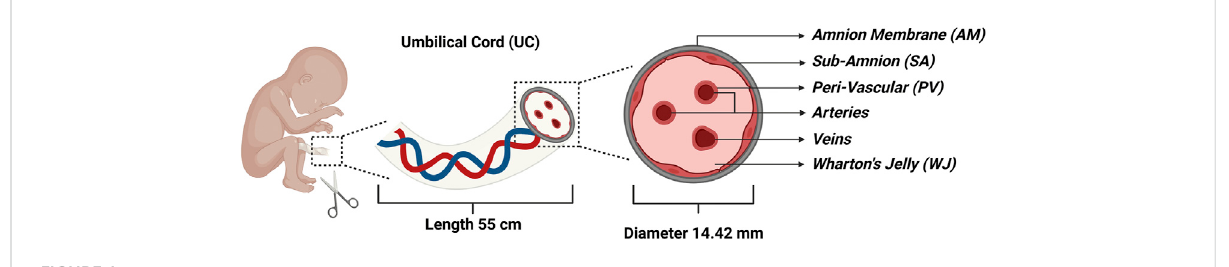
FIGURE 1 Schematic illustration of the umbilical cord (UC) representing the four major compartments: Amnion Membrane (AM), Wharton ’ s Jelly (WJ), Sub-Amnion (SA), and Peri-Vascular (PV) region along with arteries and veins.